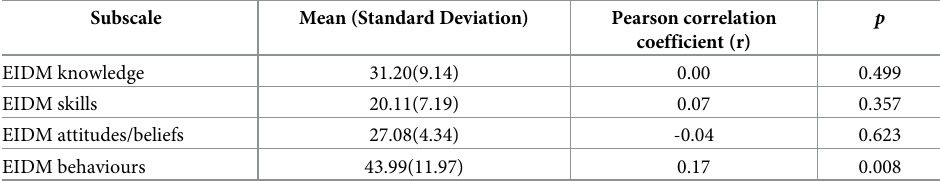
Table 6. Correlation between EIDM subscale totals and years worked as RN.